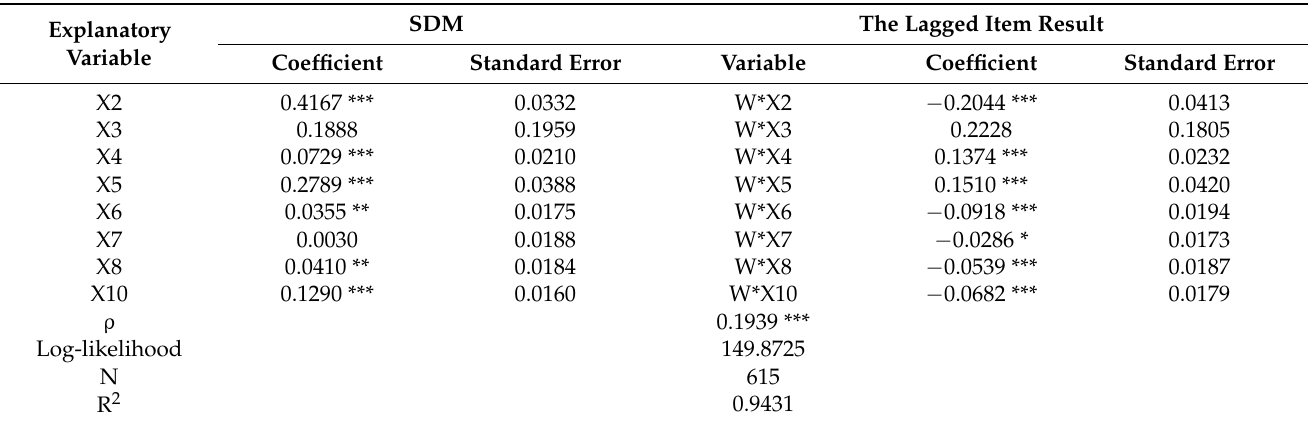
Table 10. The regression results of the robustness